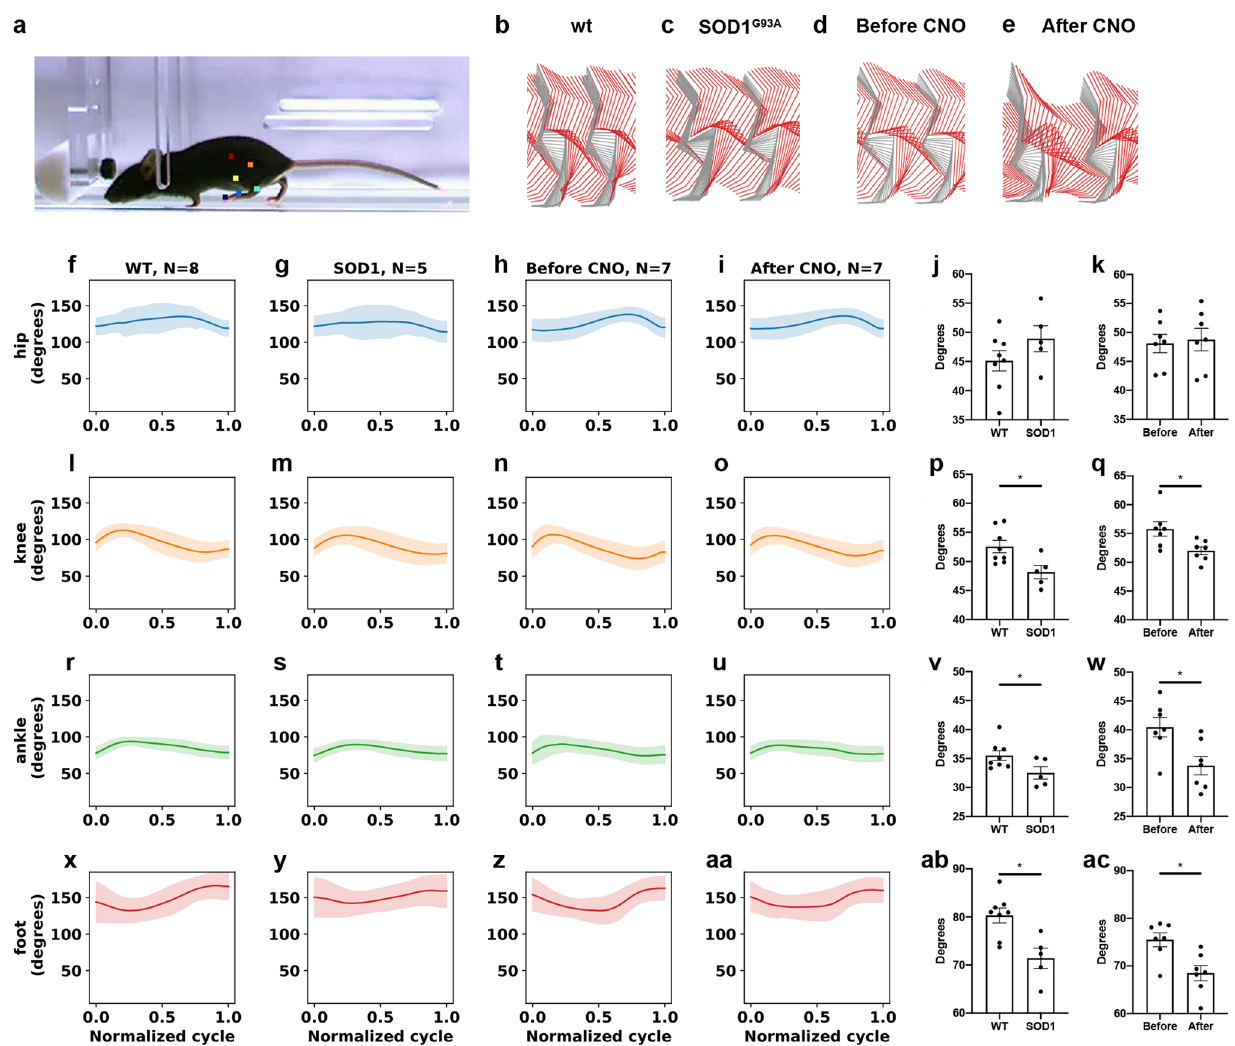
mouse analyzed with DeepLabCut tracking software. Dots mark iliac crest, hip, knee, ankle, foot and toe. Stick fi gures depicting the relative position of the analyzed joints in wild-type ( b ) and in SOD1 G93A mice after Onset of locomotor phenotype ( c ) during a complete step cycle, stance phase in gray. Stick fi gures of En1 cre ;HoxB8 FlipO ; RC::Di mice before ( d ) and after ( e ) CNO treatment show similar changes in hyper fl exion of the ankle and knee joints as in